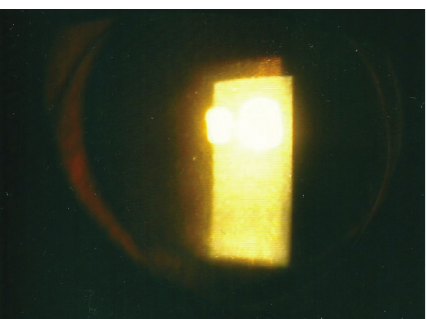
Figure 6: Slightly inferiorly displaced EK button and clear recipient